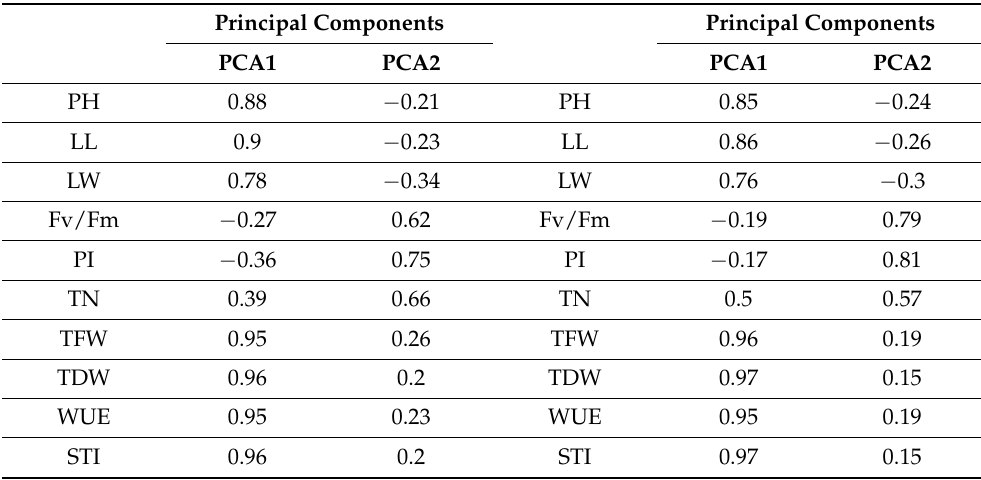
Table A3. Eigenvector matrix of principal component analysis under moderate water stress (Left) and severe water stress